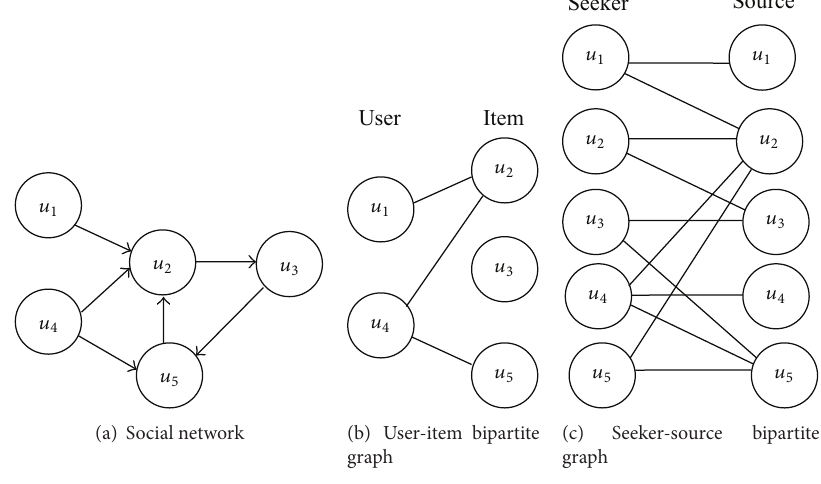
Figure 1: An example to illustrate seeker-source bipartite